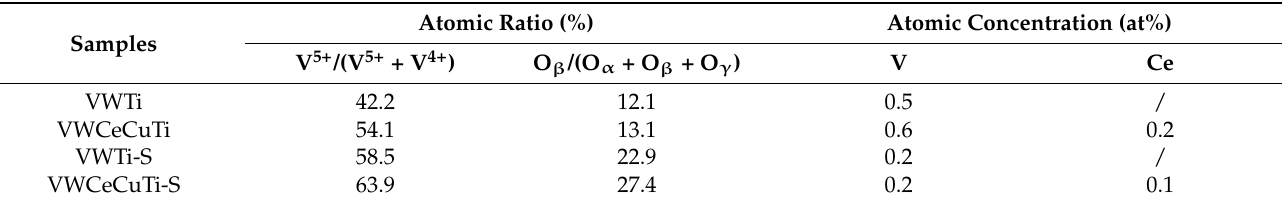
Table 3. Surface atomic ratio and concentration from